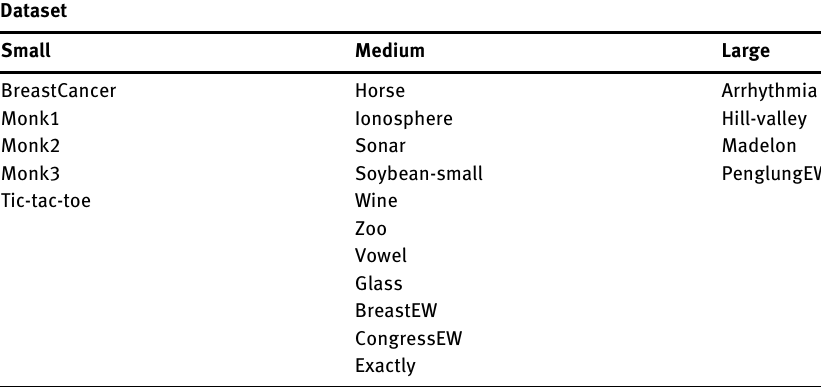
Table 1: Category-wise Names of the Datasets.